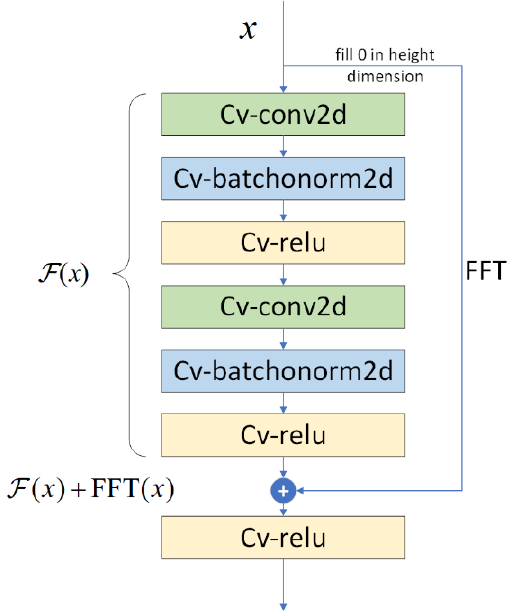
Figure 5. A complex-valued FFT residual learning block.